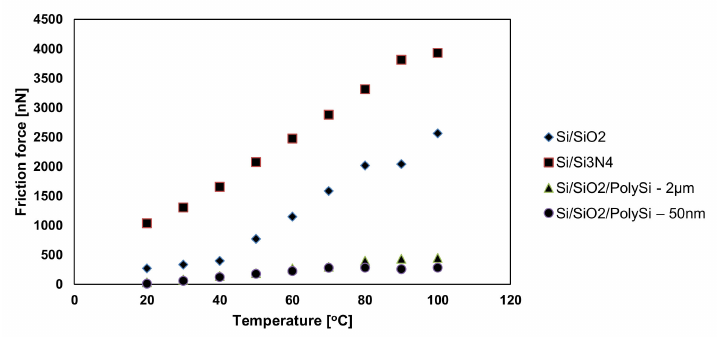
Figure 24. Friction force with respect to temperature for Si/SiO 2 ; Si/Si 3 N 4 ; Si/SiO 2 /PolySi—2 µ m and Si/SiO 2 /PolySi—50 nm.